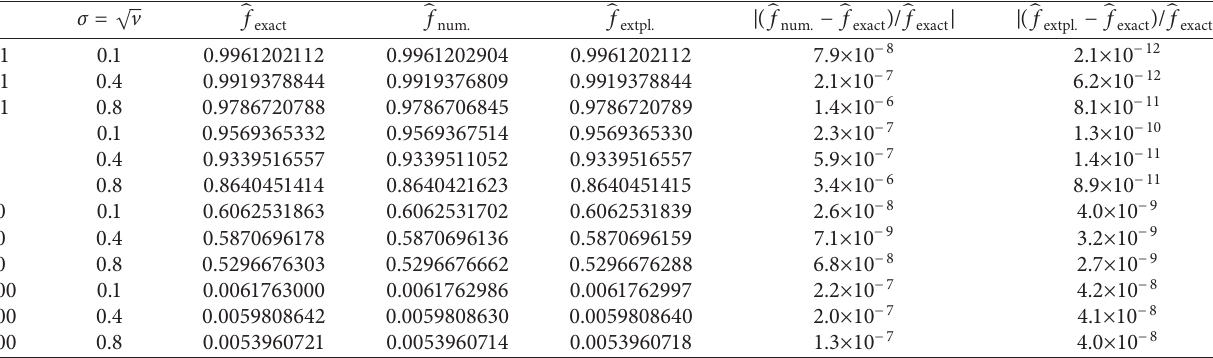
Table 2: Comparison between the exact solution 􏽢 f solution after Richardson’s extrapolation 􏽢 f numerical solutions are obtained with Δ τ � Δ v � 0 . 01.